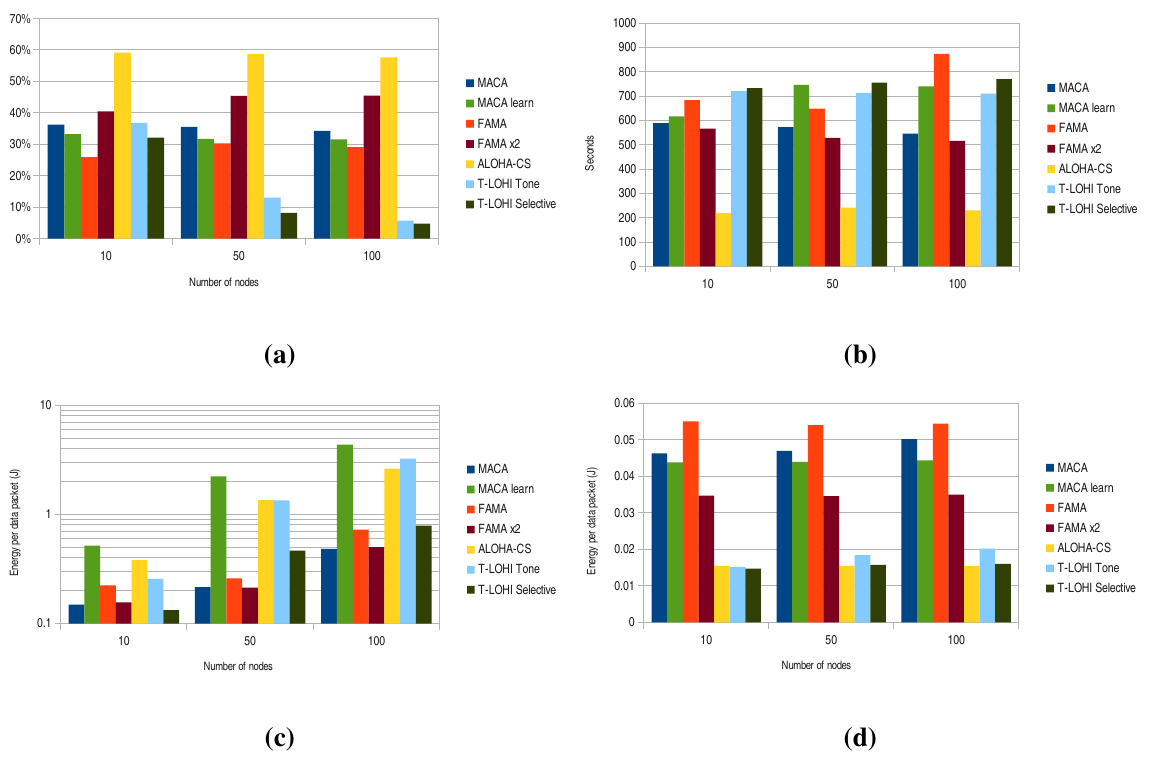
Figure 9. Results without acknowledgment. ( a ) Normalized received packets; ( b ) delay; ( c ) energy per data packet—node; ( d ) energy per data